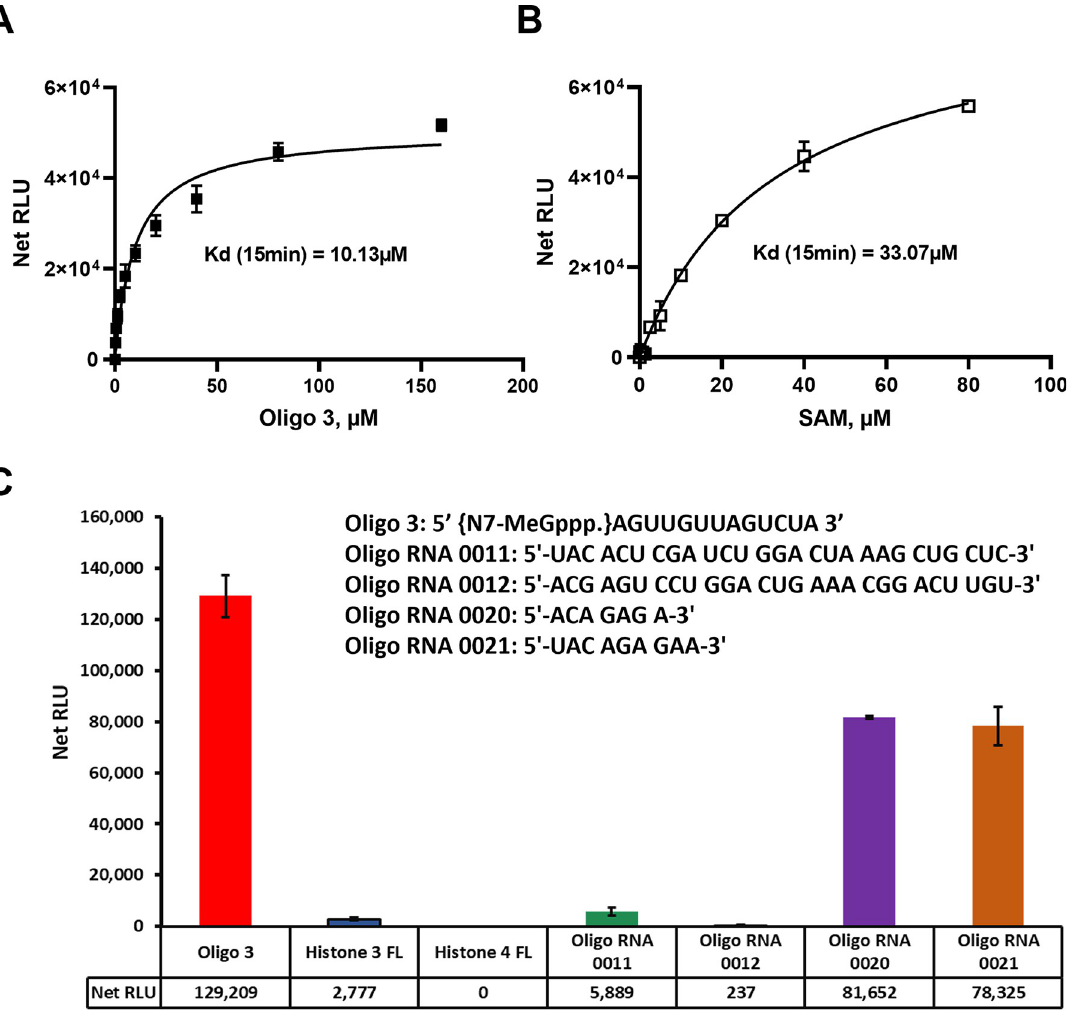
Fig 4. SARS-CoV-2 nsp10/nsp16 MTase kinetic parameters and substrate specificity. (A) SARS-CoV-2 nsp10/nsp16 substrate kinetic studies were carried out using different concentrations of Oligo 3 using 20 μ M SAM per reaction. (B) Similar studies with the